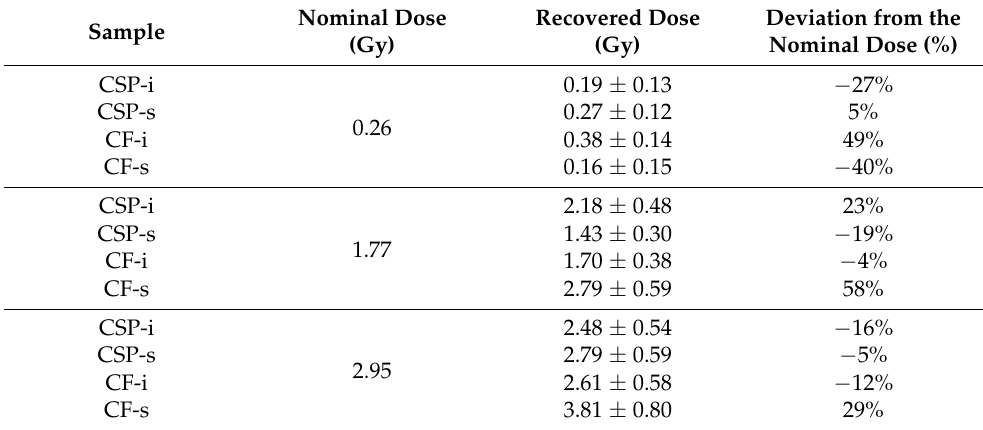
Table 3. Results of the dose recovery test using camera lens glass